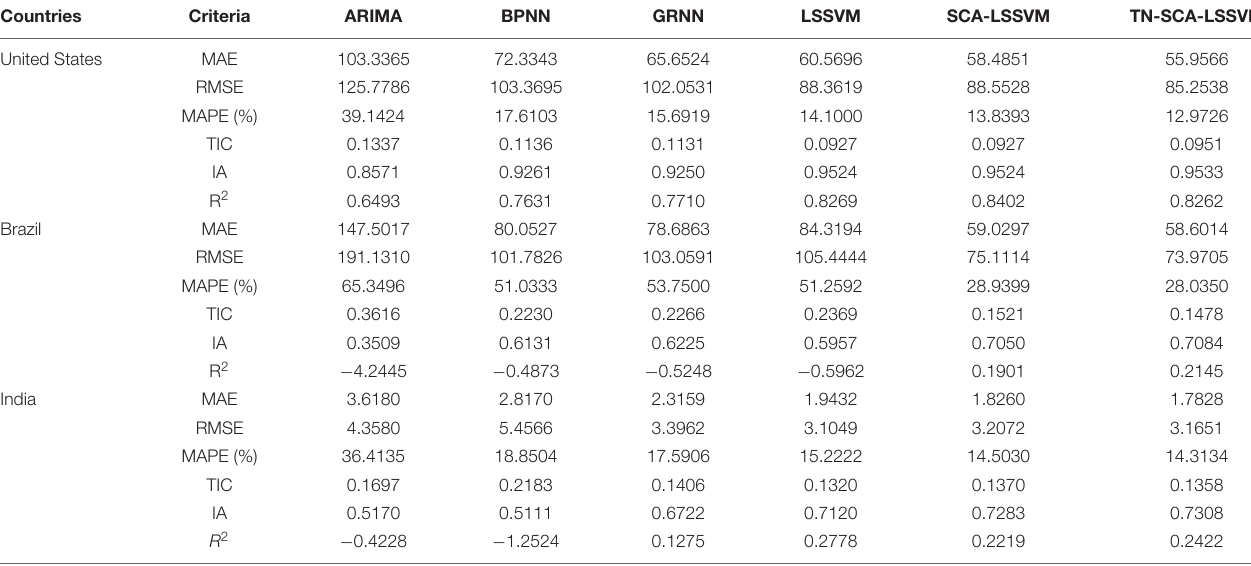
TABLE 5 | The comparative forecasting error of different models for COVID-19 new cases. Countries